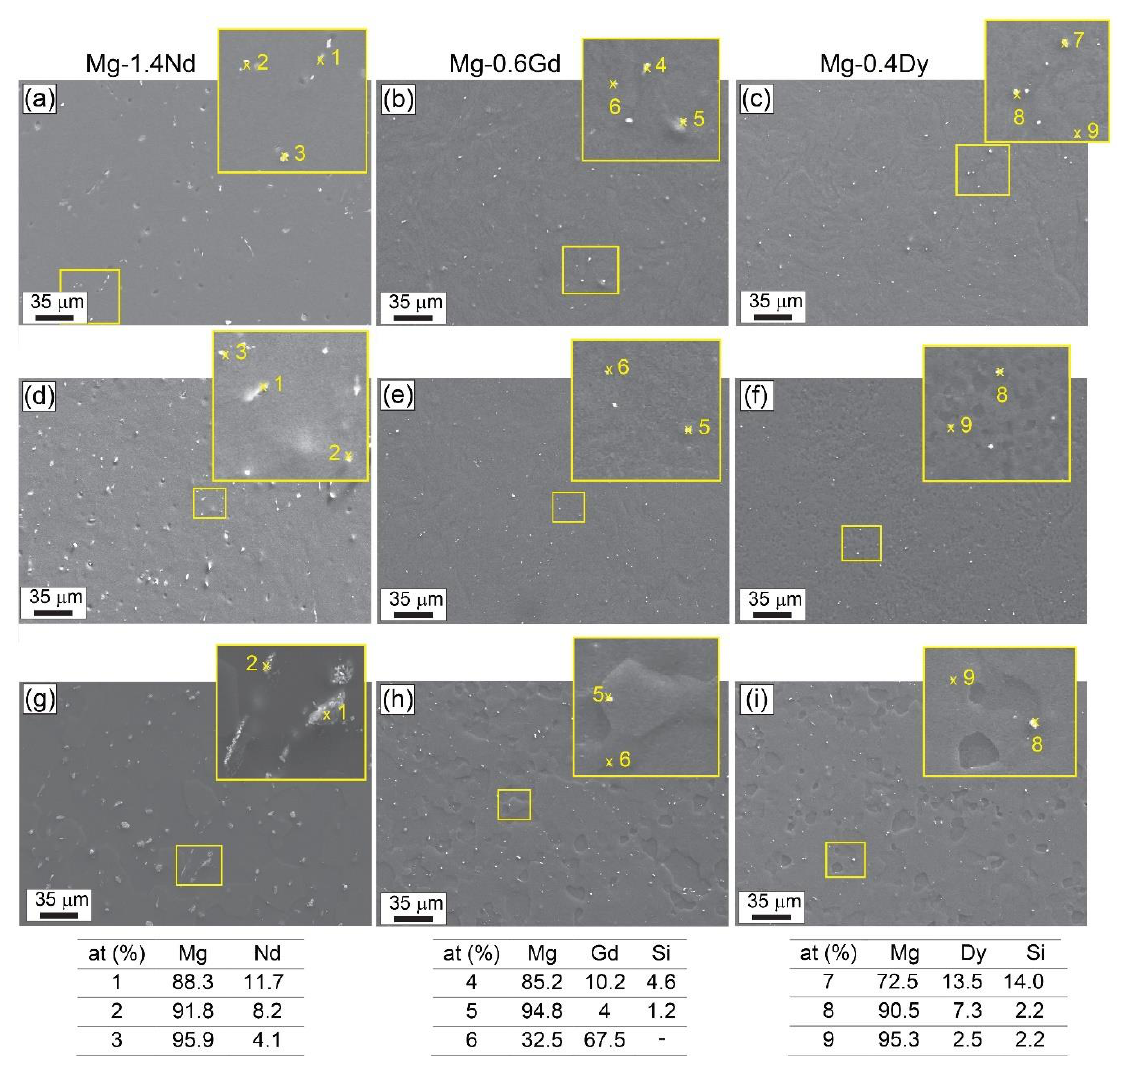
Figure 5. SEM photos of HPT-processed: ( a ) Mg-1.4Nd, ( b ) Mg-0.6Gd, ( c ) Mg-0.4Dy, annealed at 250 ◦ C for 1 h: ( d ) Mg-1.4Nd, ( e ) Mg-0.6Gd, ( f ) Mg-0.4Dy and annealed at 450 ◦ C for 1 h: ( g ) Mg-1.4Nd, ( h ) Mg-0.6Gd, and ( i ) Mg-0.4Dy